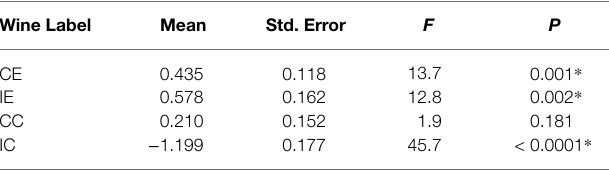
TABLE 3 | Mean of the PCN amplitudes for each bottle/label averaged across sessions from 120 to 160 ms, standard errors of the mean, and results of F tests as deviation from